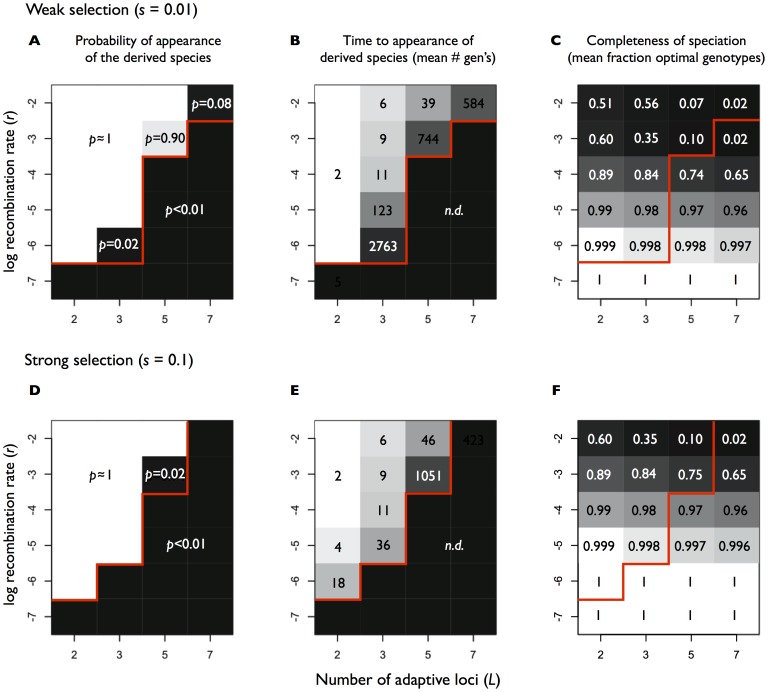
Results of symsim model under step fitness.(A, B, C) Weak selection. (D, E, F) Strong selection. See Figure 2 legend.